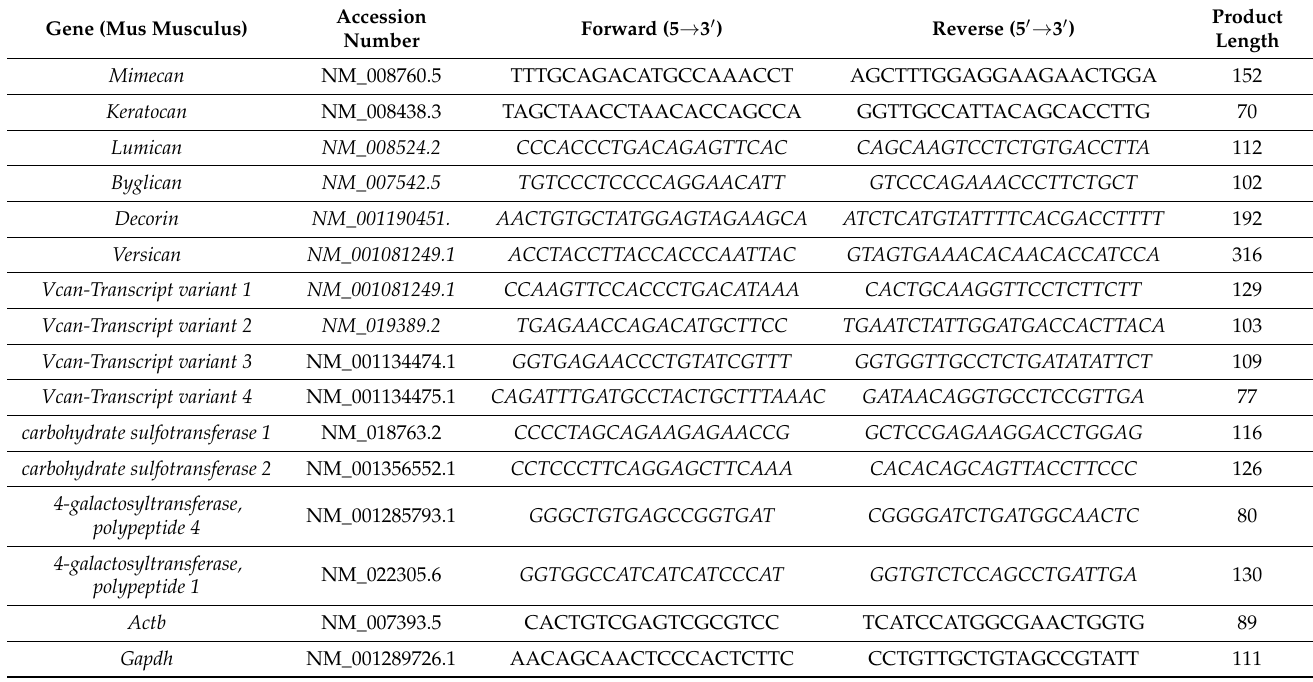
Table 4. Primers used for real time PCR